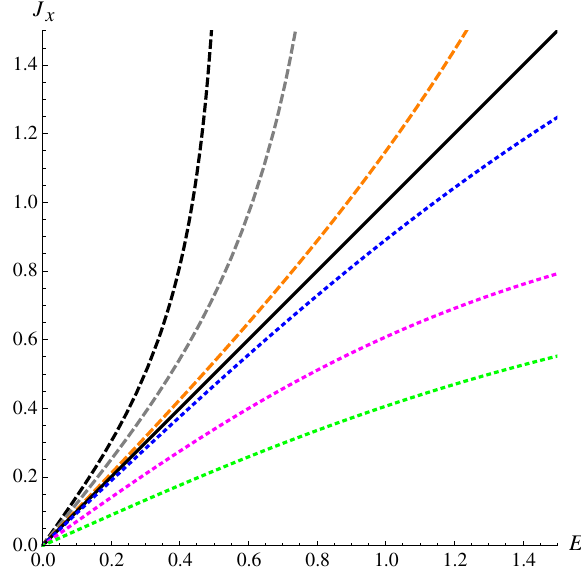
Fig. 11 The current–voltage behavior for BI model. We set μ = u = 1, and the parameter γ from top to down is h 1 , 0 . 5 , 0 . 1 , 0 , − 0 . 1 , − 0 . 5 , − 0 .